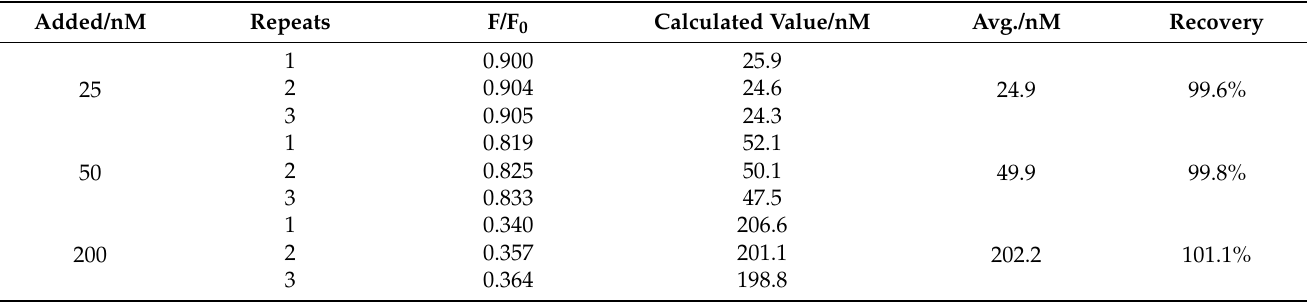
Table 2. Average recoveries of Hg 2+ in the pond water samples ( n = 3).